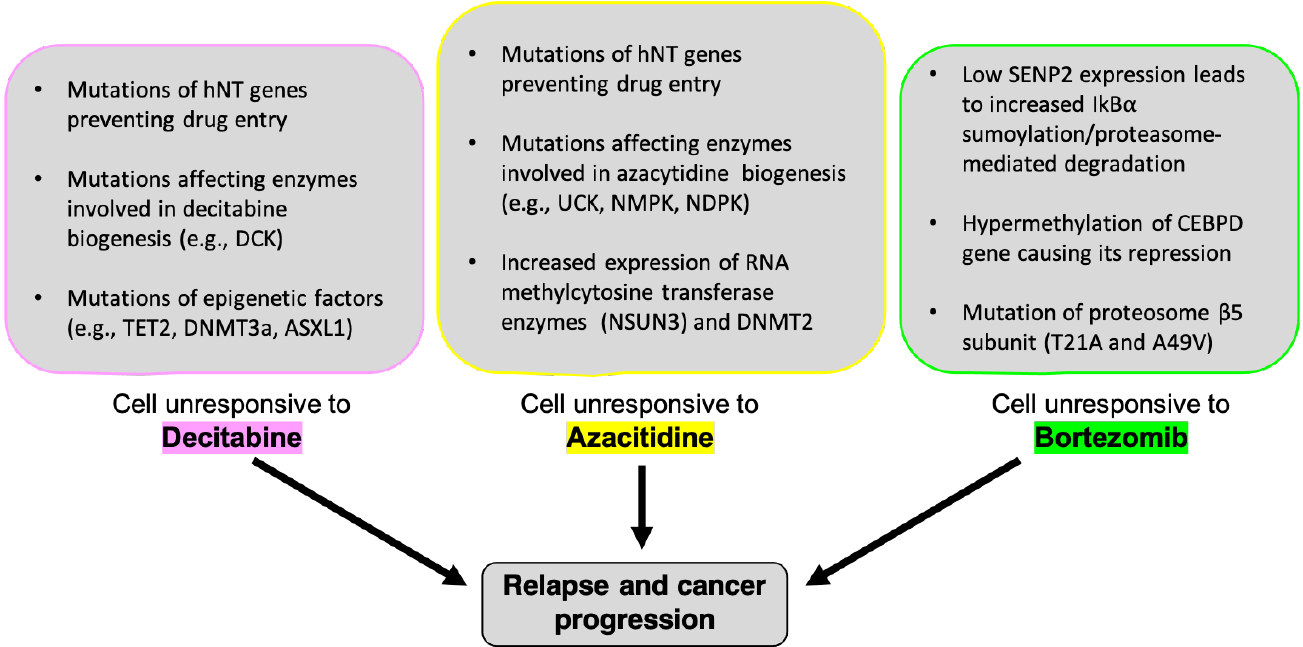
Figure 4. Mechanisms of drug resistance in hematological malignancies. The mechanisms of cellular resistance to decitabine and azacitidine are still under investigation, however, several studies have begun to elucidate processes associated with resistance to both drugs. Mutations in epigenetic proteins (i.e., DNMT1, DNMT3a, TET2, and ASXL1) are often associated with decitabine [and azacitidine] resistance; these genetic alterations result in a hindered DNA methylation process and interfere with both drug’s ability to induce hypomethylation. Recent research has uncovered connections between